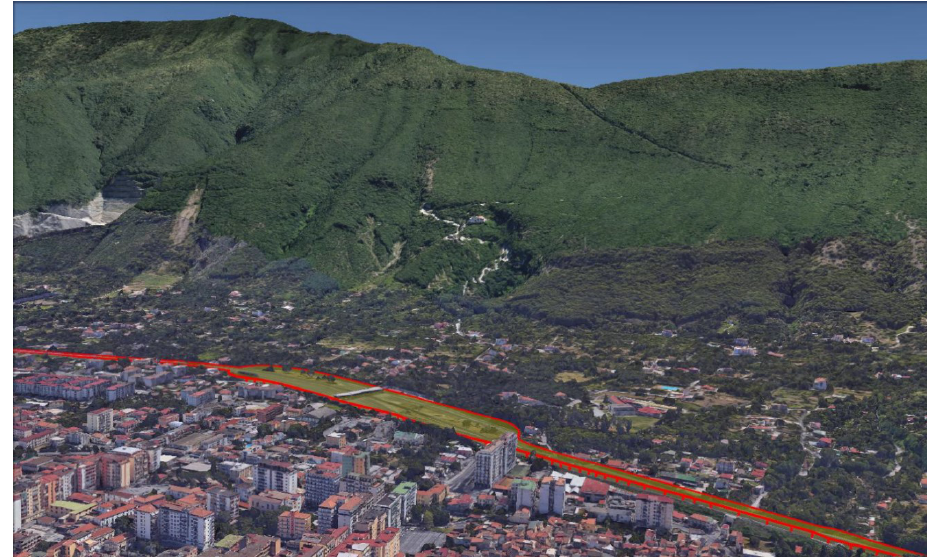
Figure 3. Infrastructure-scale view of the study area with the A3 Salerno–Reggio-Calabria motorway (boundaries marked in red).